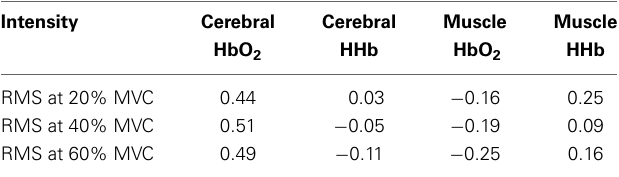
Table 3 | Pearson correlations between electromyographic and cerebral/muscle hemodynamic responses during intermittent contractions of the biceps brachii at three intensities ( N = 11, critical ‘ r ’ value =